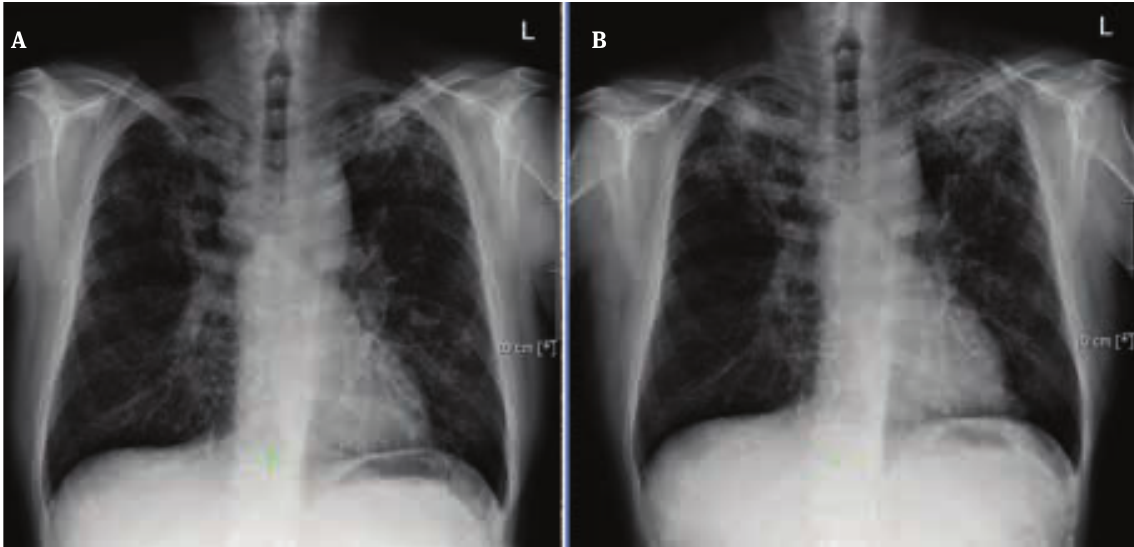
Figure 5: A: Chest X- ray 2 weeks after the initiation of the tuberculosis therapy. B: Chest X- ray 6 weeks after the discontinuation of adali- mumab therapy, it revealed progressive pulmonary infiltrates in term of paradoxical